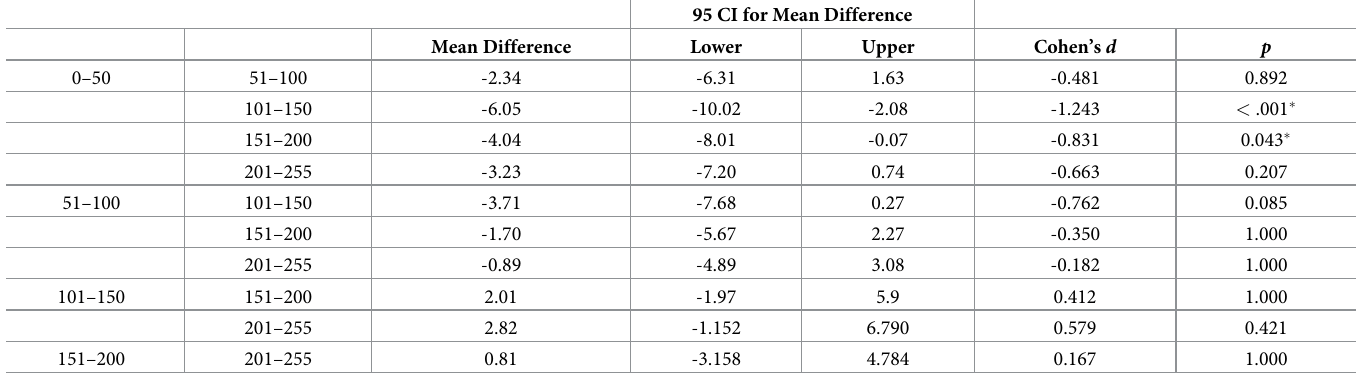
Table 2. 50 A.U. band pairwise comparisons following one-way